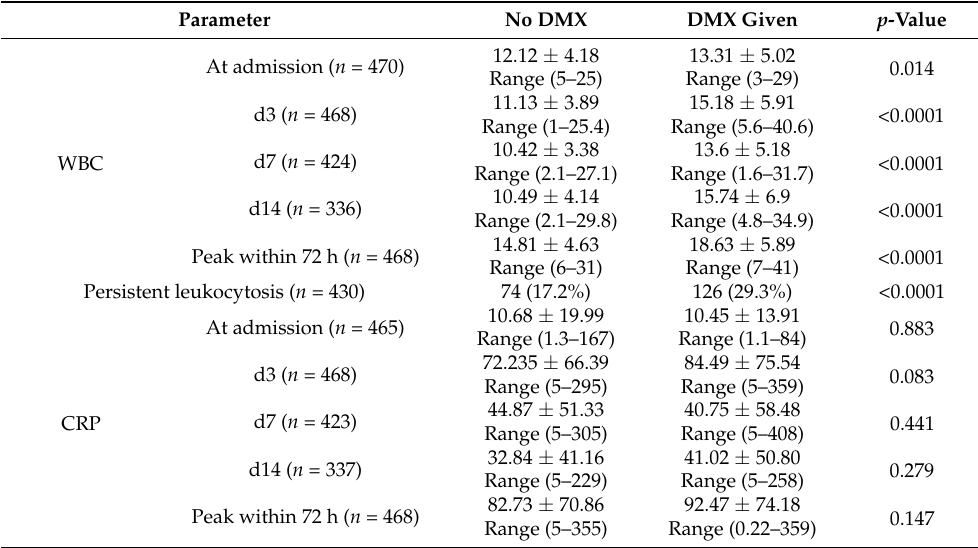
Table 2. White blood cell counts and C-reactive protein values at multiple timepoints.